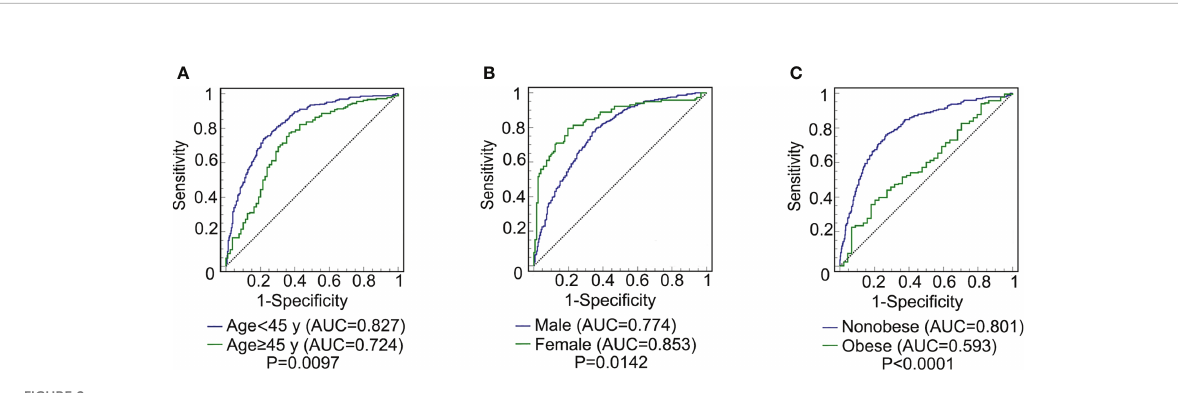
FIGURE 2 ROC curve comparison of CMI prediction of MAFLD among different subgroups. (A) comparison between young (age < 45) and middle-age and elderly (age ≥ 45 y) subjects ( P = 0.0097); (B) comparison between male and female subjects ( P = 0.0142); (C) comparison between non-obese and obese subjects ( P < 0.0001). CMI, cardiometabolic index; MAFLD, metabolic-associated fatty liver disease; ROC, receiver operating characteristic; AUC, area under the ROC.